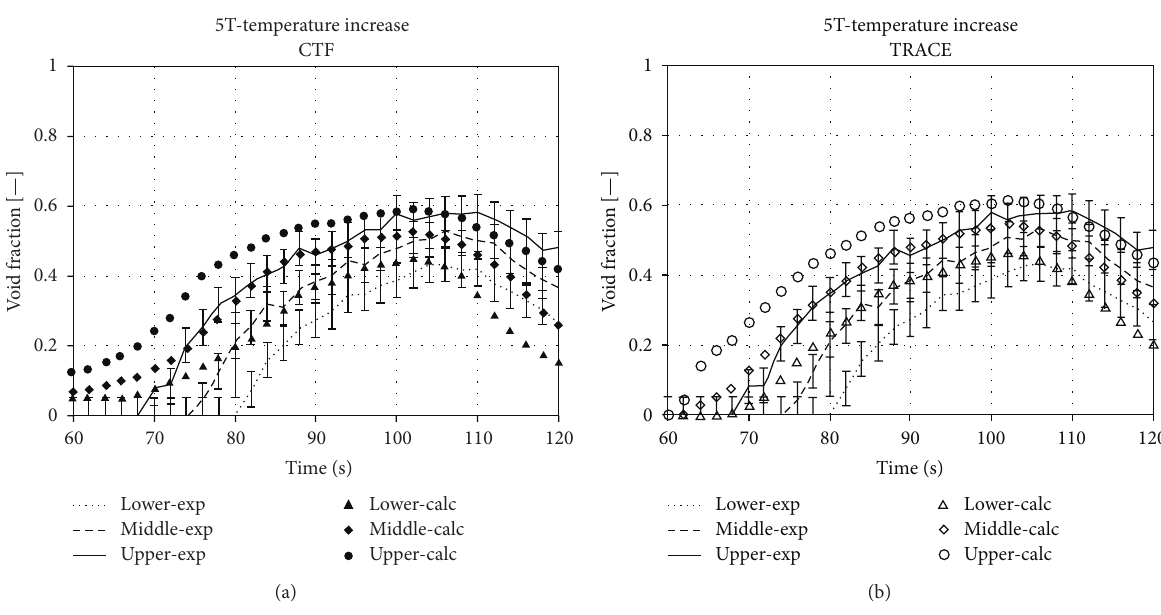
Figure 6: CTF (a) and TRACE (b) predictions of void fraction in bundle type B5 during temperature increase